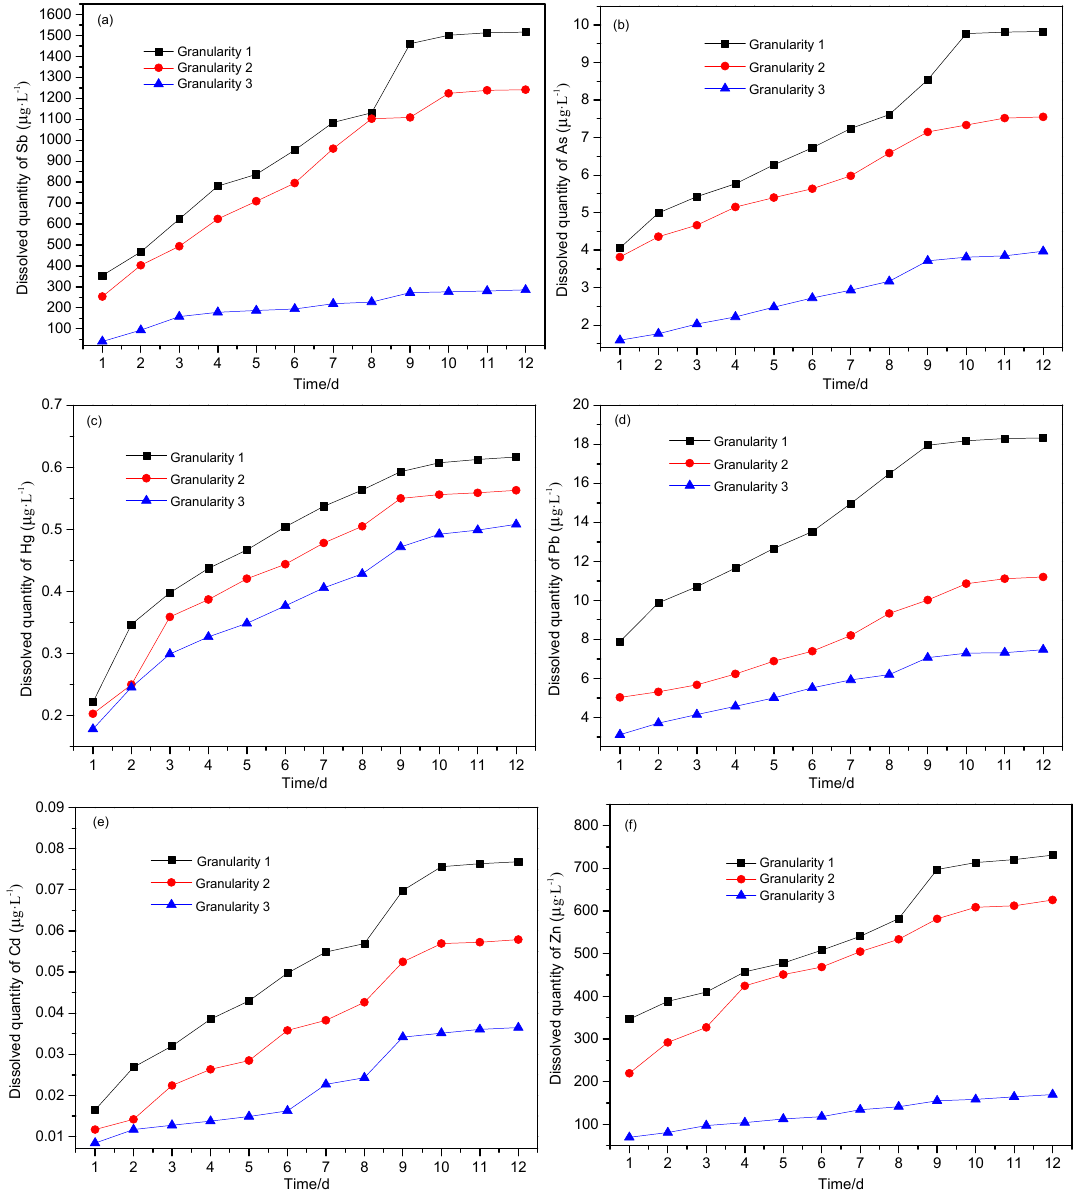
Figure 6. The soluble portion of PTEs over time from different solid phase particle sizes. ( a ) Sb; ( b ) As; ( c ) Hg; ( d ) Pb; ( e ) Cd; ( f ) Zn.